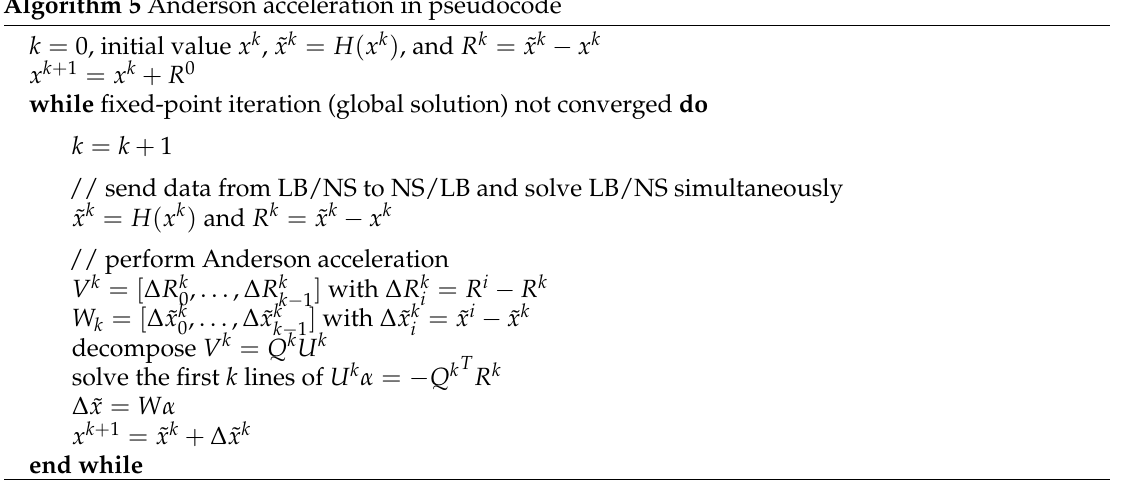
Algorithm 5 Anderson acceleration in